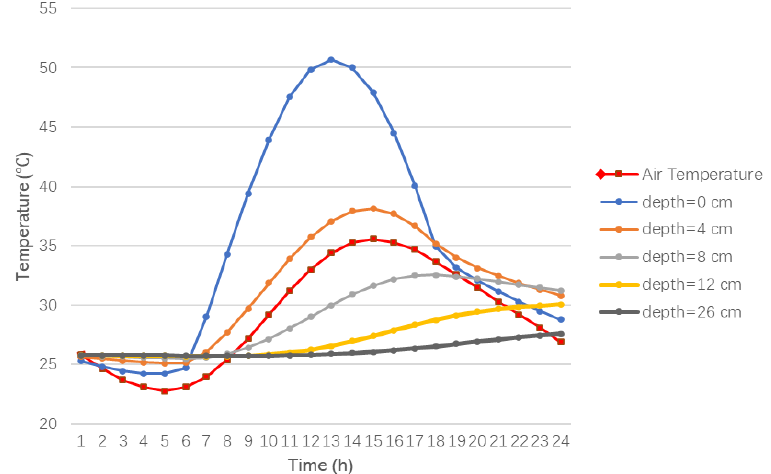
Figure 4. Hourly air temperature and temperature of the asphalt layers at different depths in the